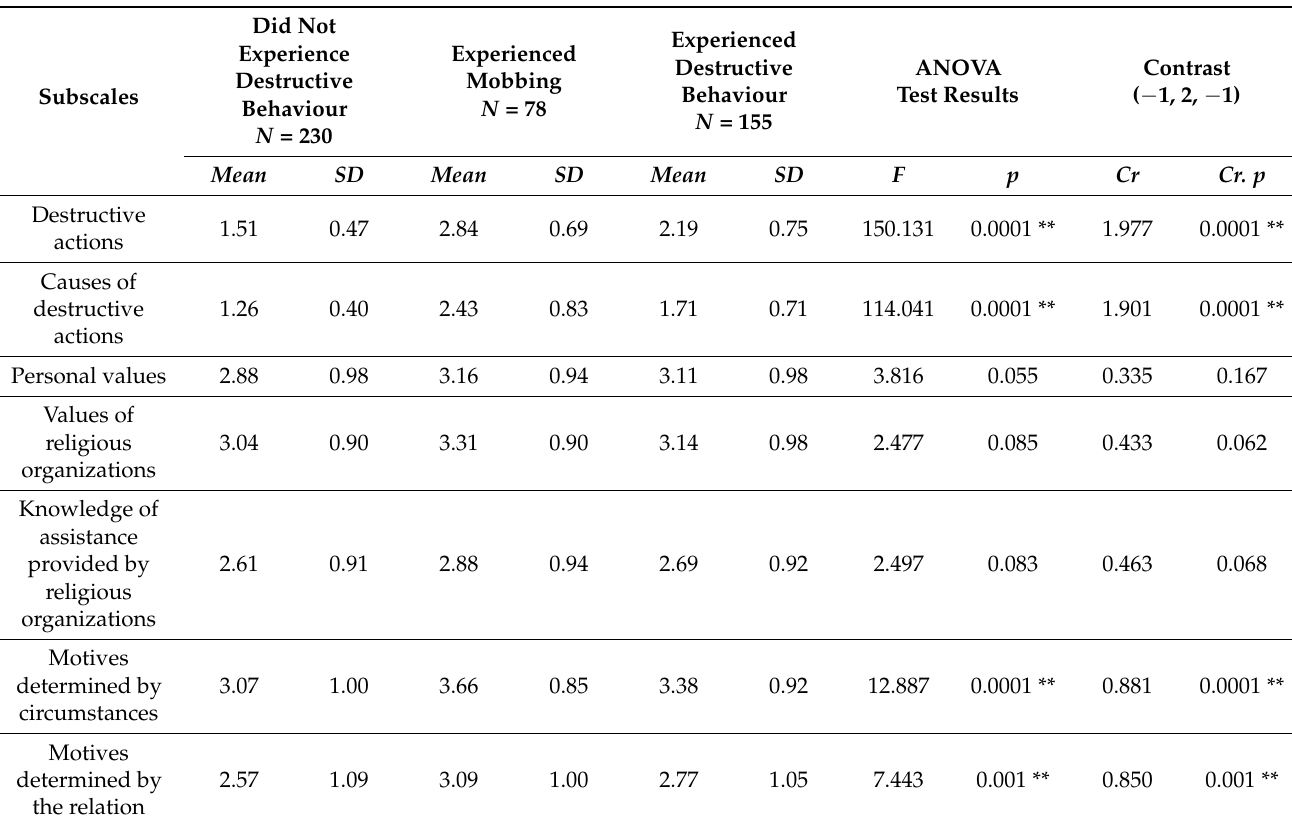
Table 4. The ANOVA test at the subscale level by the nature of the